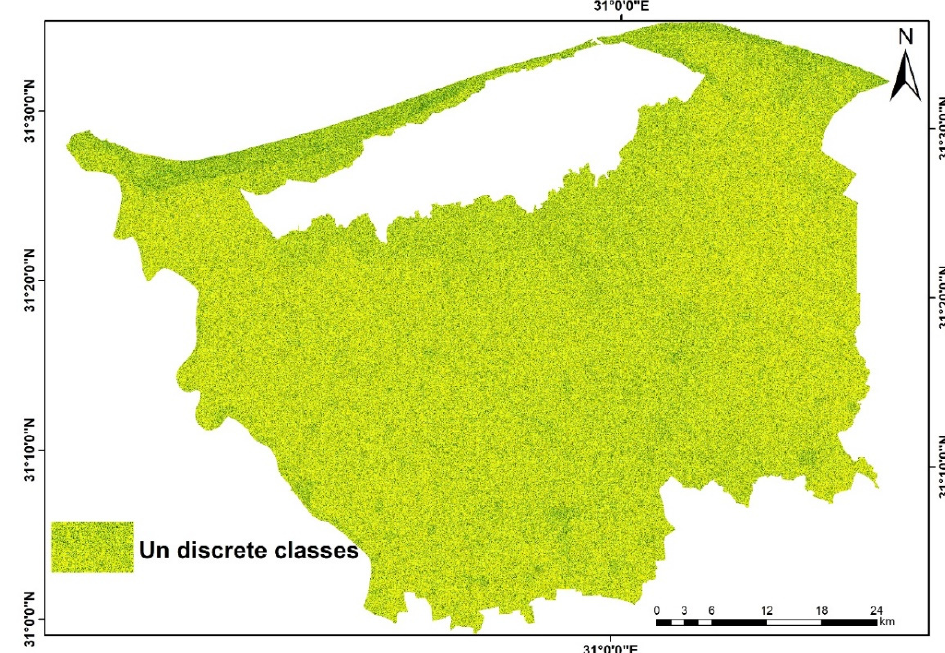
Figure 10 . A 2002 map showing the SAfSoil results from the indices of Setia et al. [73].